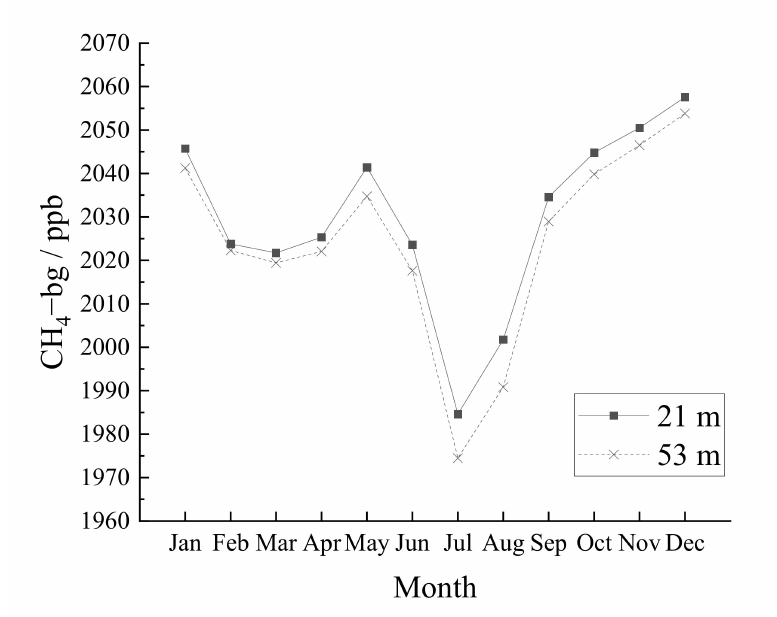
Figure 5. Seasonal variations in the CH 4 background concentration at Lin’an